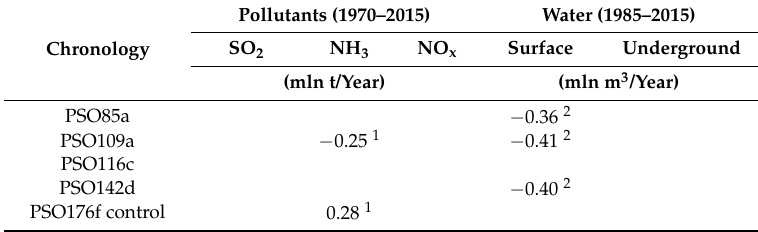
Table 5. Significant dependence between residual site chronologies of Scots pine and the annual emission of gaseous air pollutants, as well as the annual amount of surface and groundwater collected for the production of fertilisers by Zakłady Azotowe